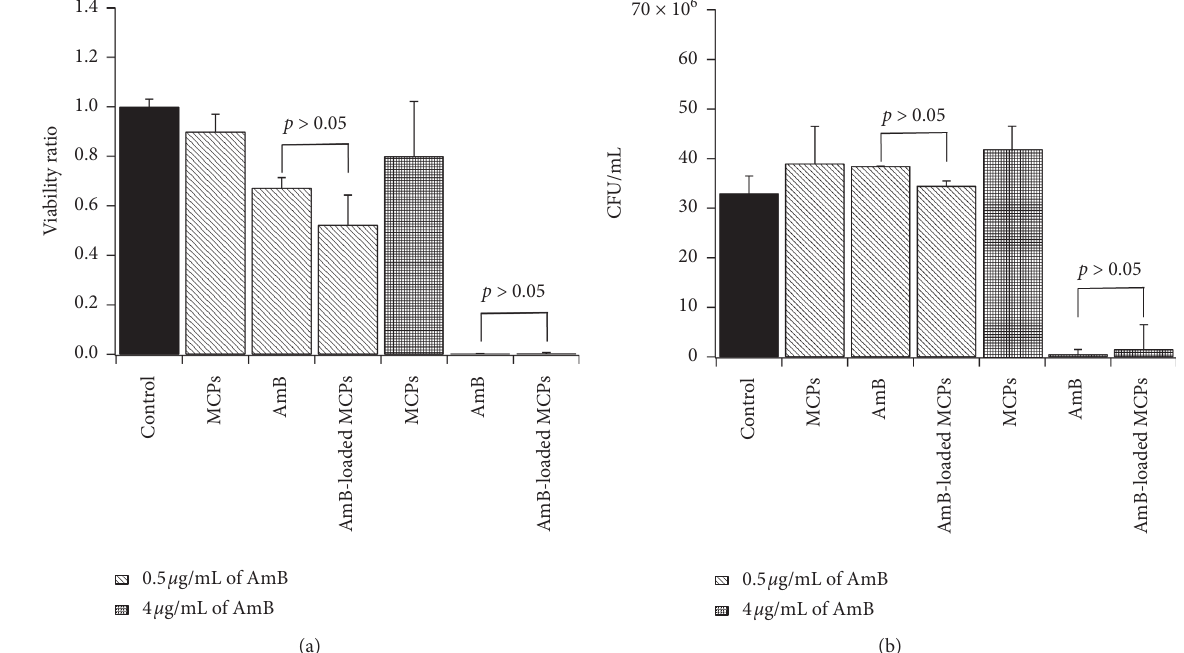
Figure 5: Cell viability: (a) viability ratio and (b) CFU/mL of Candida albicans cells treated with free AmB or AmB-loaded MCPs for 48 hours. The amount of AmB-loaded MCPs added corresponded to an equivalent amount of free AmB. MCPs represent blank microparticles at the concentration used for AmB-loaded MCPs. Error bars represent the standard error of two independent experiments.